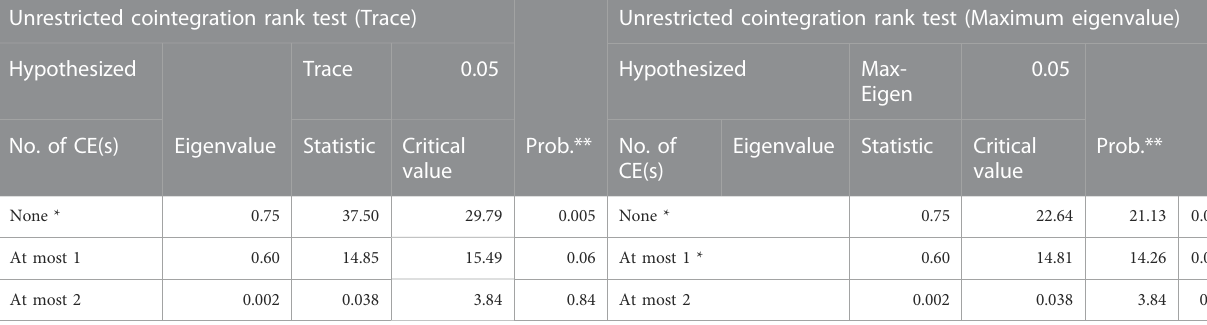
TABLE 3 Unrestricted Cointegration Rank Test, using Trace and Max-eigenvalue tests.